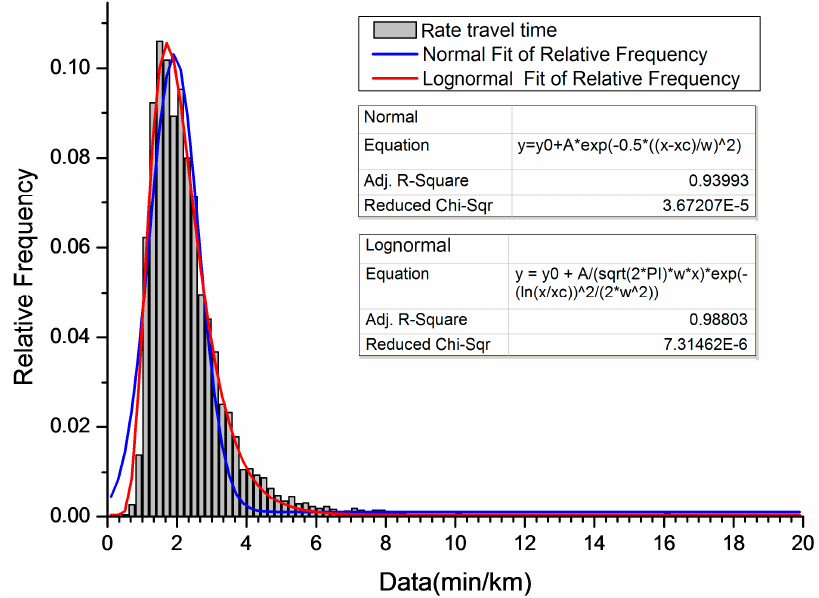
Figure 6. Distribution of road travel times.